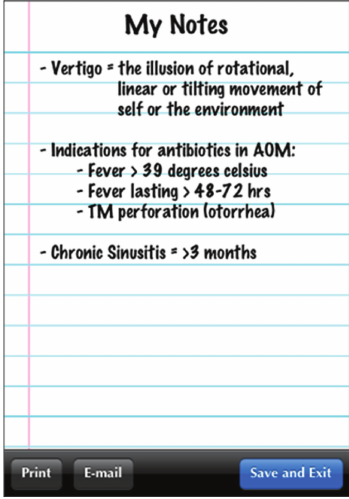
Figure 10: “My Notes” section allows users to save, print, and email notes without exiting the app.